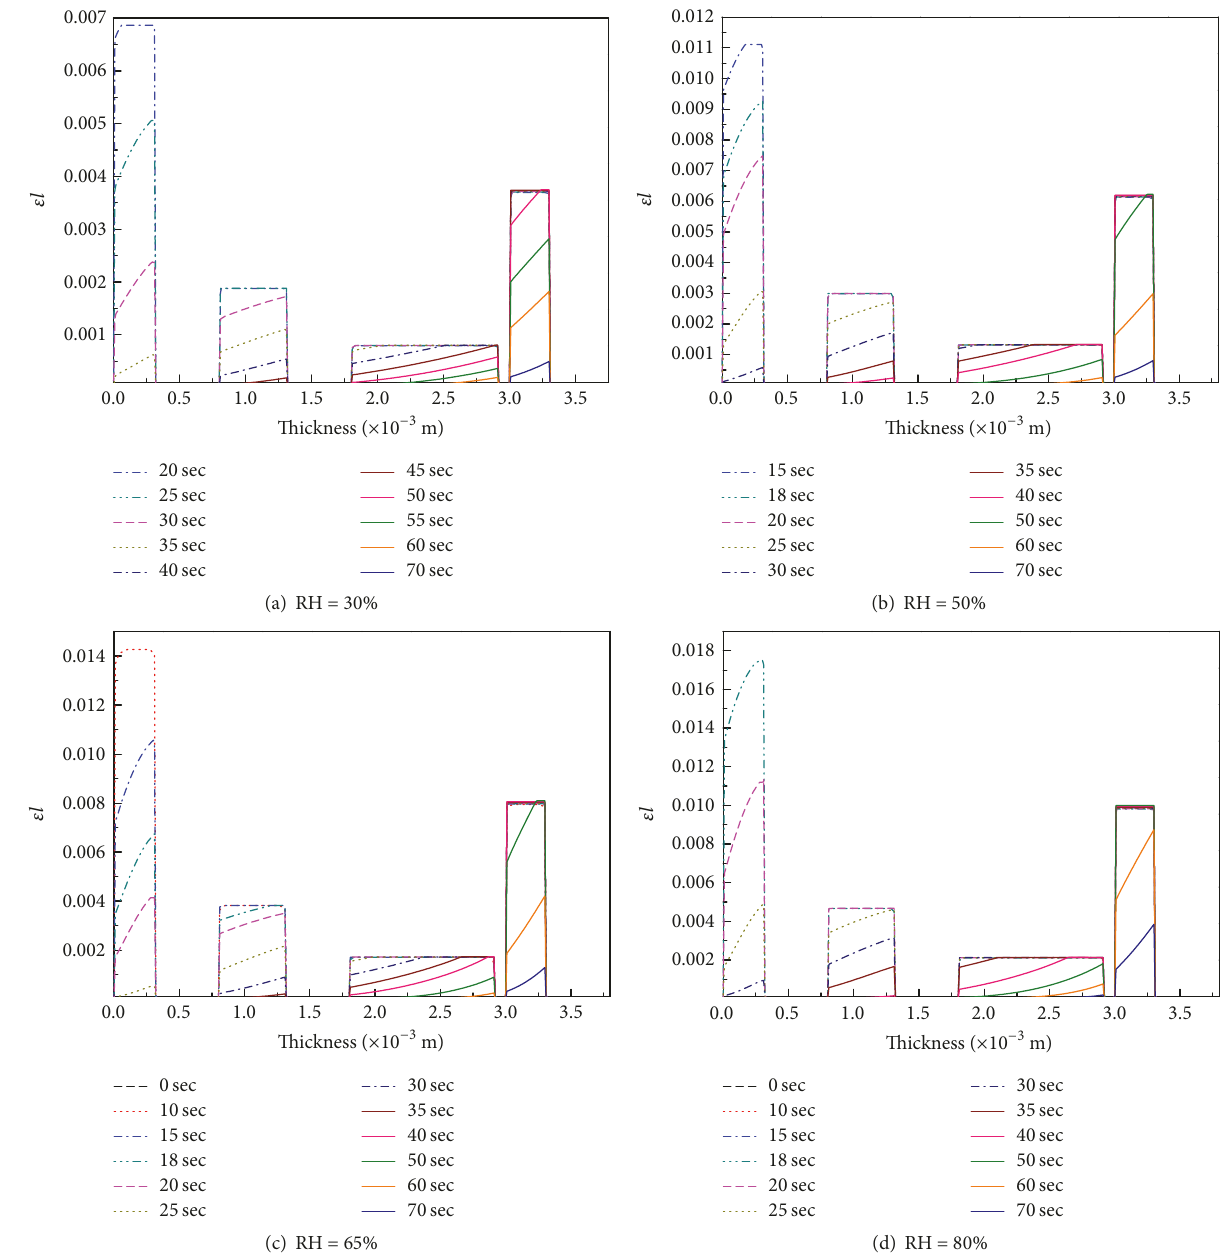
Figure 12: Liquid water volume fraction distributions at different